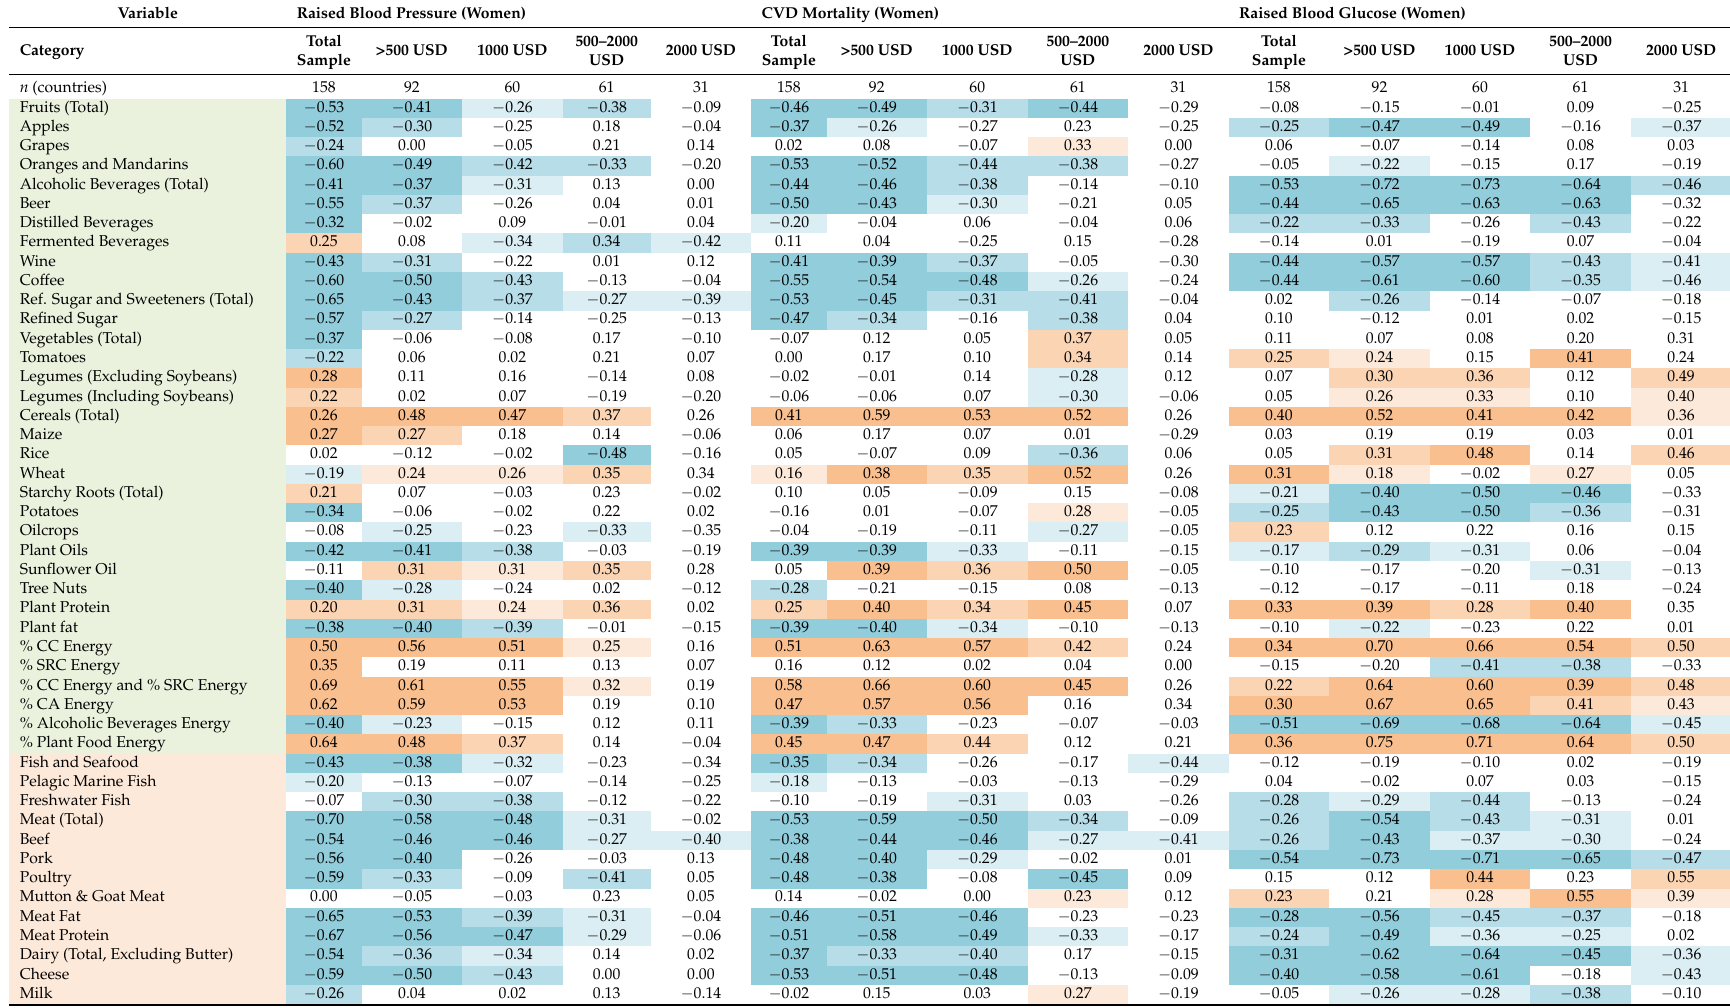
Table 5. Pearson linear correlations in women: differences according to health expenditure per capita (constant 2011 international USD, 2012). Variable Raised Blood Pressure